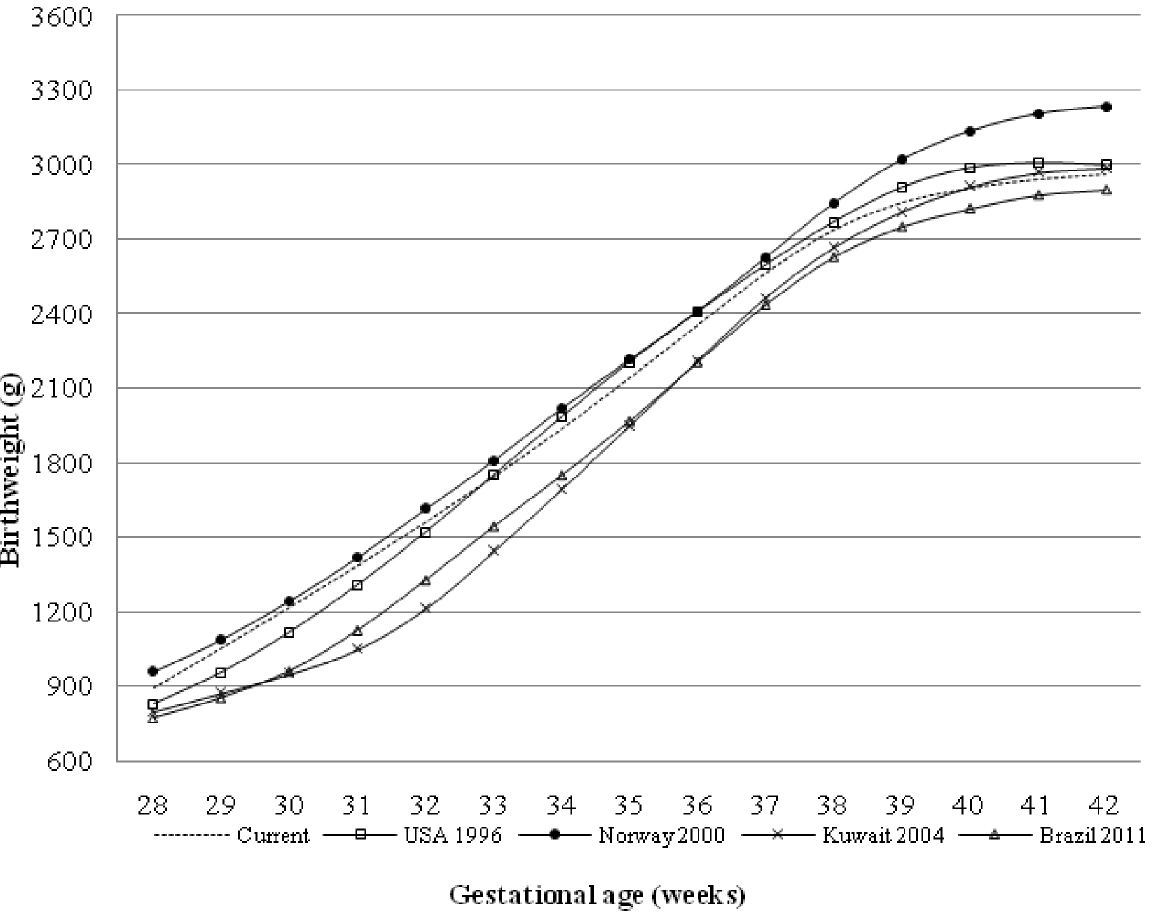
Figure 4. Comparison of the 10 th birth weight percentiles for boys between the current study, USA, Norway, Kuwait and Brazil.